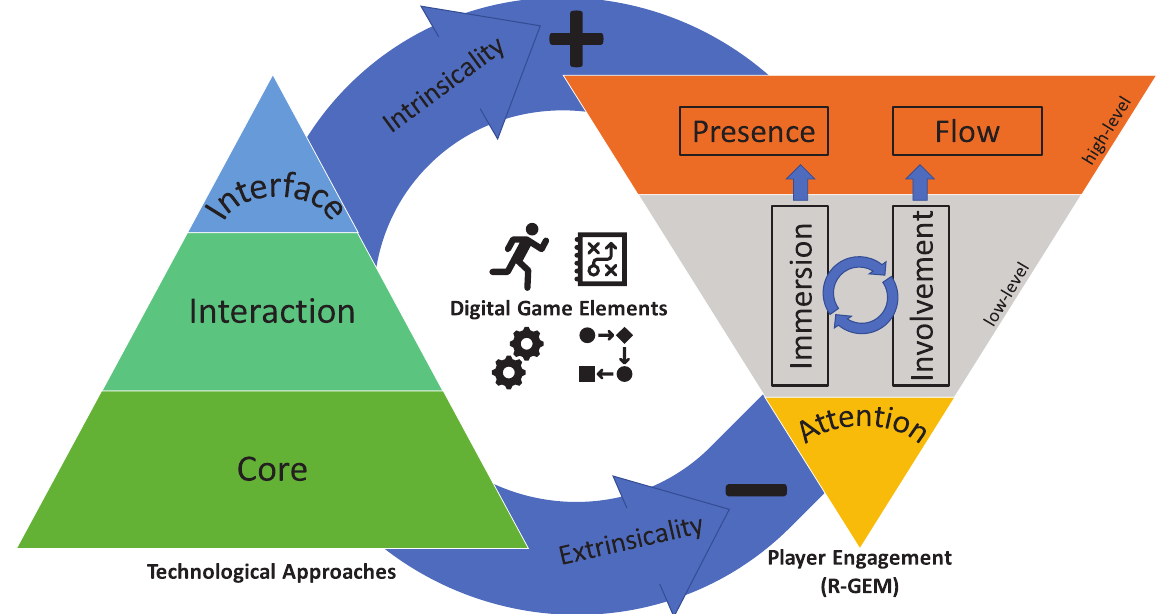
Figure 1. How the framework relates to digital game elements and player engagement. Note: Player engagement model is adapted from Procci et al.